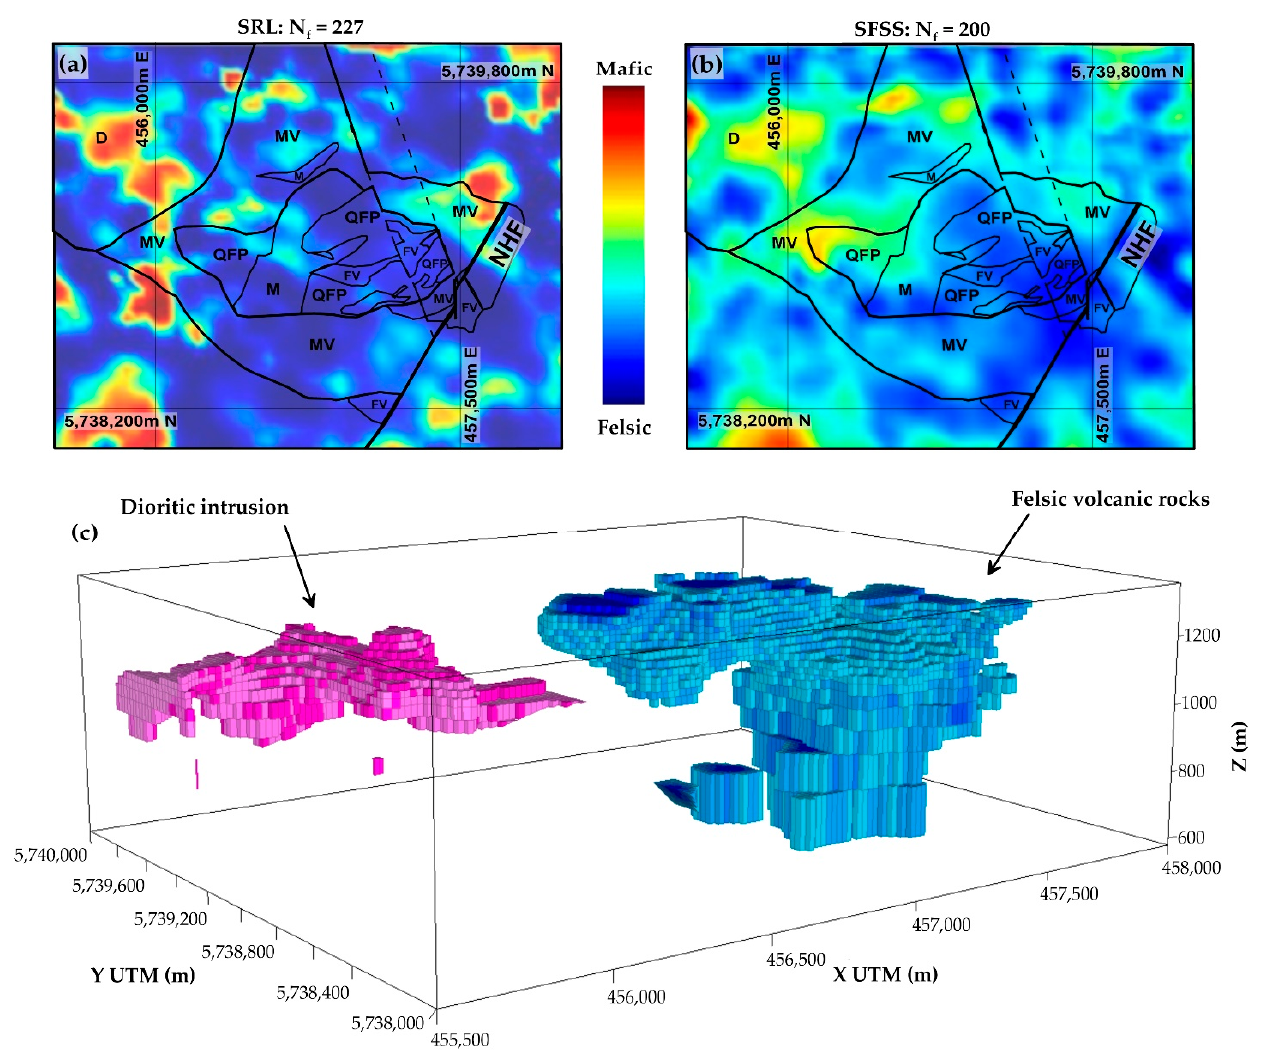
Figure 10. Results of SRL lithotype predictions ( a ) versus SFSS lithotype predictions ( b , c ). SFSS resulted in the better reconstruction of lithotypes with a smaller number of input spectral features (Nf = 200). Results are sliced horizontally at the elevation of 1000 m.